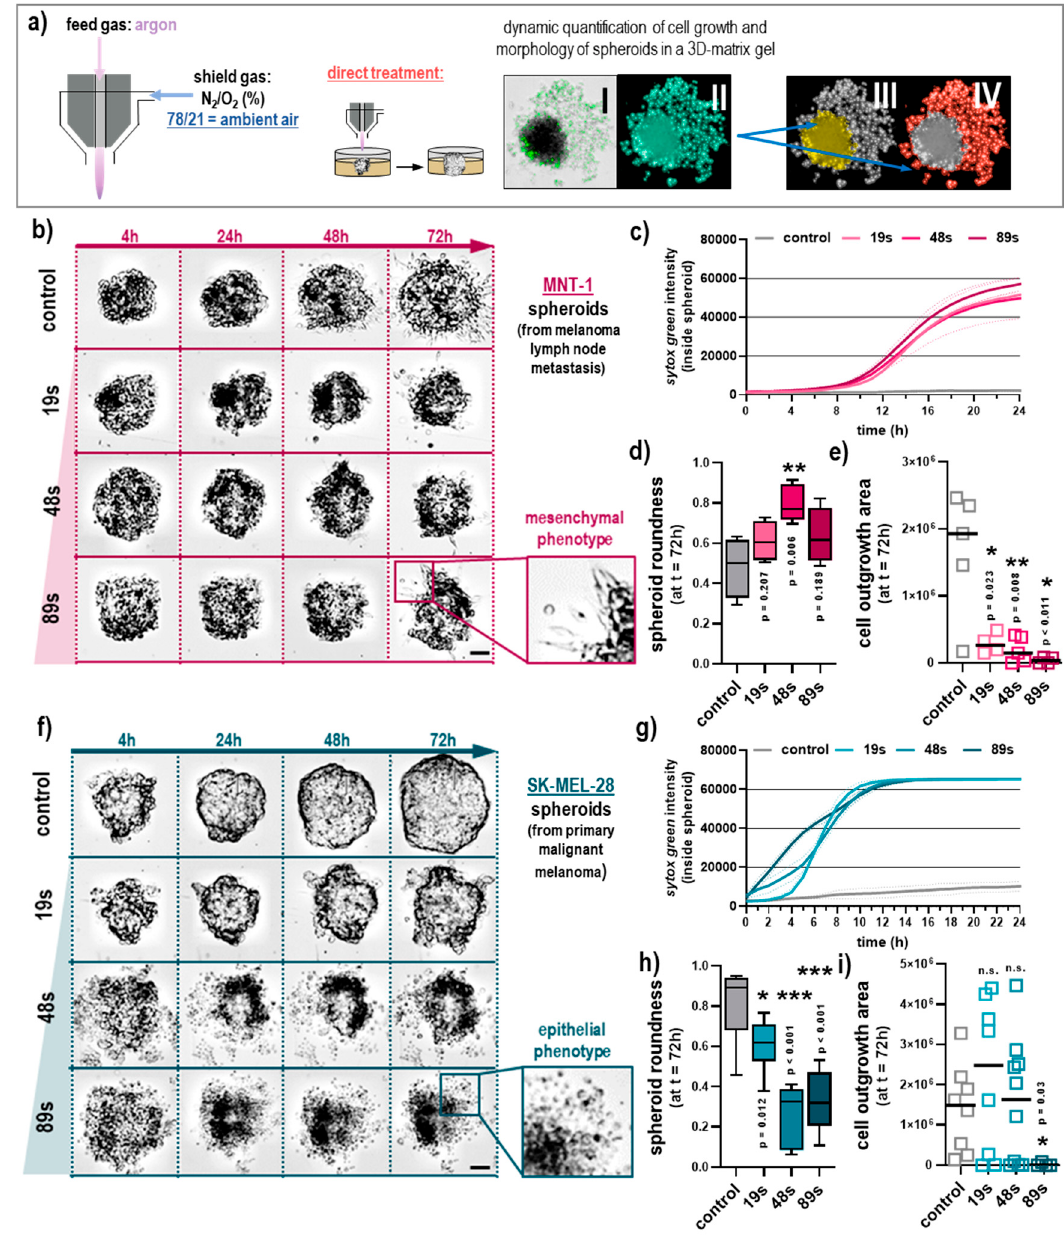
Figure 4. Quantification of evasion properties in plasma-treated melanoma spheroids under ambient air conditions in a 3D-matrix gel. ( a ) Schematic presentation of the workflow and the high-content image analysis showing the brightfield and sytox green overlay image (I), the total area segmented from that image (II), the spheroid core segmentation (III), and the segmented region containing cells outside of the spheroid core (IV); ( b ) representative images of plasma-treated MNT-1 spheroids; ( c ) live-cell imaging of MNT-1 spheroids over 24 h and quantification of the cell death marker kinetics; ( d ) morphological analysis of MNT-1 tumor spheroids at 72 h; ( e ) quantification of viable MNT-1 cells growing outside the core tumor spheroid at 72 h; ( f ) representative images of plasma-treated SK-MEL-28 spheroids; ( g ) live-cell imaging of SK-MEL-28 spheroids over 24 h and quantification of the cell death marker kinetics; ( h ) morphological analysis of SK-MEL-28 tumor spheroids at 72 h; ( i ) quantification of viable SK-MEL-28 cells growing outside the core tumor spheroid at 72 h. Data are mean ± S.E., boxplots, or mean with individual values and of two independent experiments with four replicates each, the sytox green kinetics show the mean (solid lines) and SD (dashed lines). Statistical analysis was performed using one-way analysis of variances comparing with Dunnett posthoc testing with p < 0.05 (*), p < 0.01 (**), and p < 0.001 (***). Scale bar = 100 µM; n.s. = not significant.